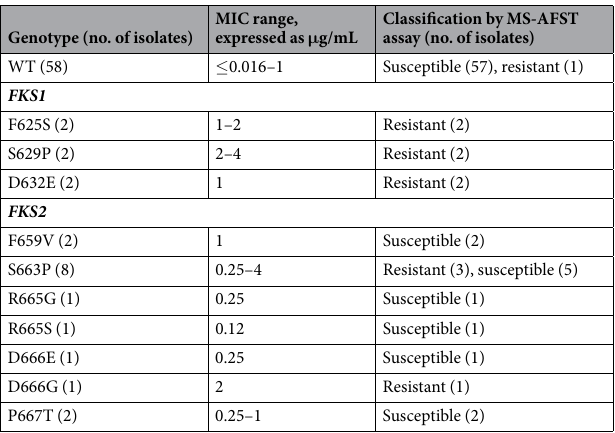
Table 1. MS-AFST assay results for the 80 C. glabrata isolates tested against anidulafungin. Classification of the isolates as susceptible or resistant to the antifungal drug is shown according to the FKS HS1 genotypes and MIC